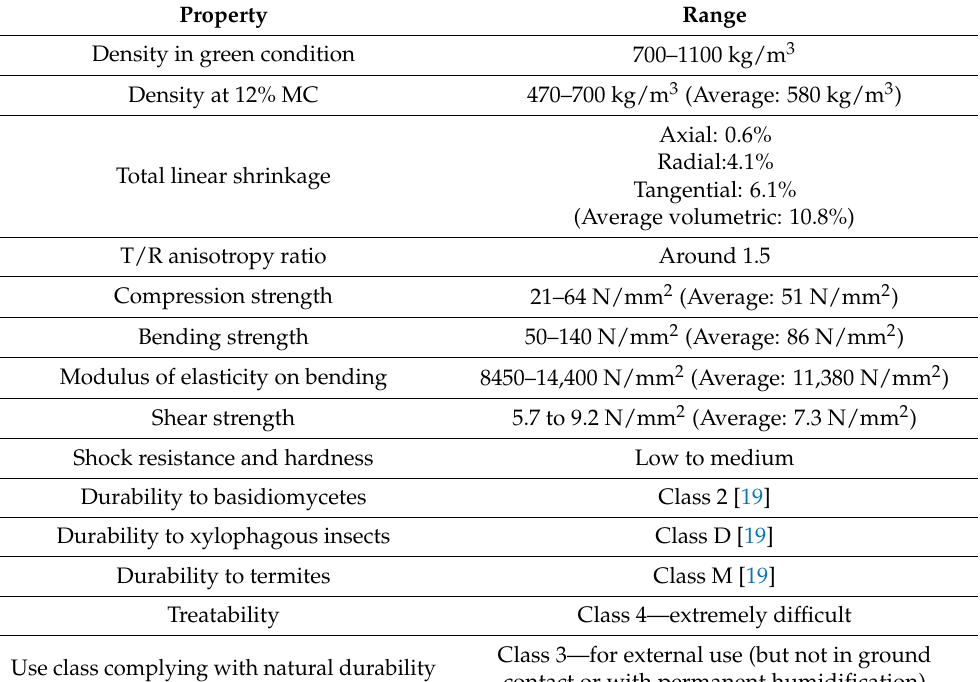
Table 1. Properties related to engineering of defect-free chestnut timber